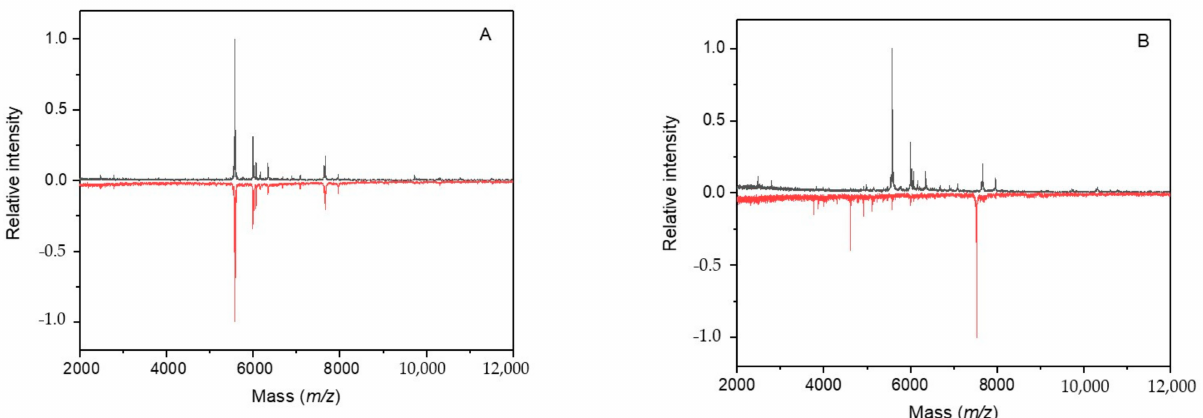
Figure 6. IC MALDI-TOF MS of Synechococcus sp. UPOC S4 grown in microgravity conditions. The spectra were acquired on Microflex LRF20 MALDI-TOF instrument using the dried-droplet sample preparation technique with FASA binary matrix. Subfigures ( A , B ) show results after cultivation for 6 and 17 days, respectively: top spectrum in black—control; bottom spectrum in red—treated cells (intensities are multiplied by − 1 for